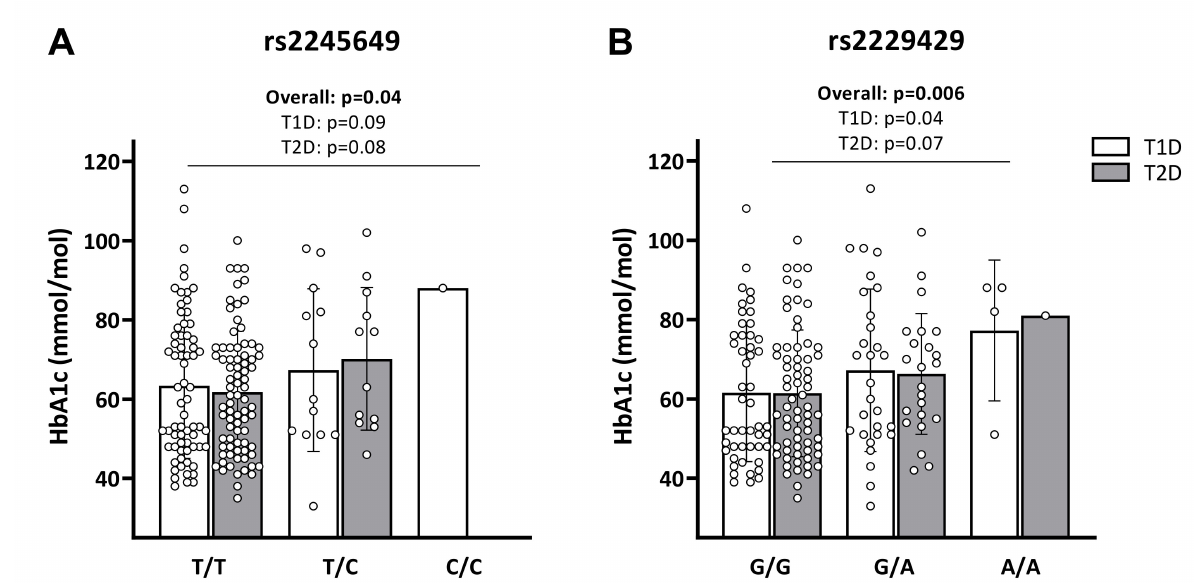
Figure 1. Serum HbA1c levels by INSR SNPs genotypes. HbA1c levels (mmol/mol) of patients with T1D ( n = 82, white bars) and patients with T2D ( n = 92, grey bars) by genotype distribution of ( A ) INSR rs2245649 and ( B ) rs2229429. Trend test was performed with linear regression, adjusted for age, sex, BMI, and insulin dosage.